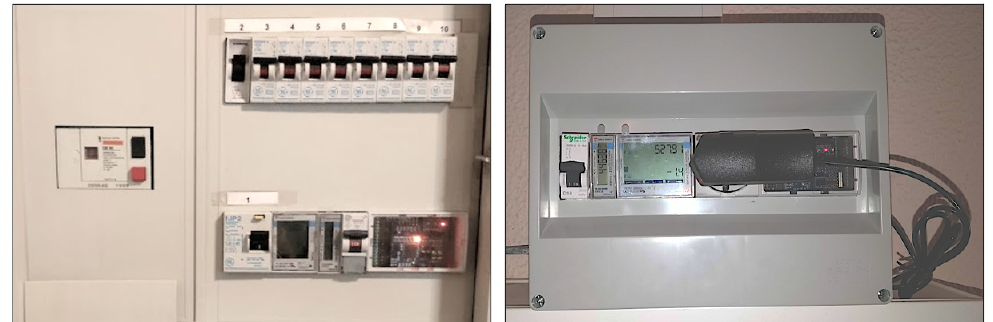
Figure 2. Example of two installation from the case study. On the site at left all the equipment was installed in the site main breaker box. The picture at right depicts another site in which all the installed equipment had to be installed in a adjunct box.